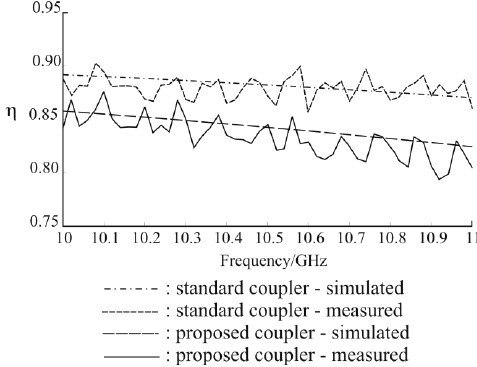
Figure 6. Comparison (loss efficiency η ) between the proposed coupler, and the standard coupler with the same inter-line spacing.